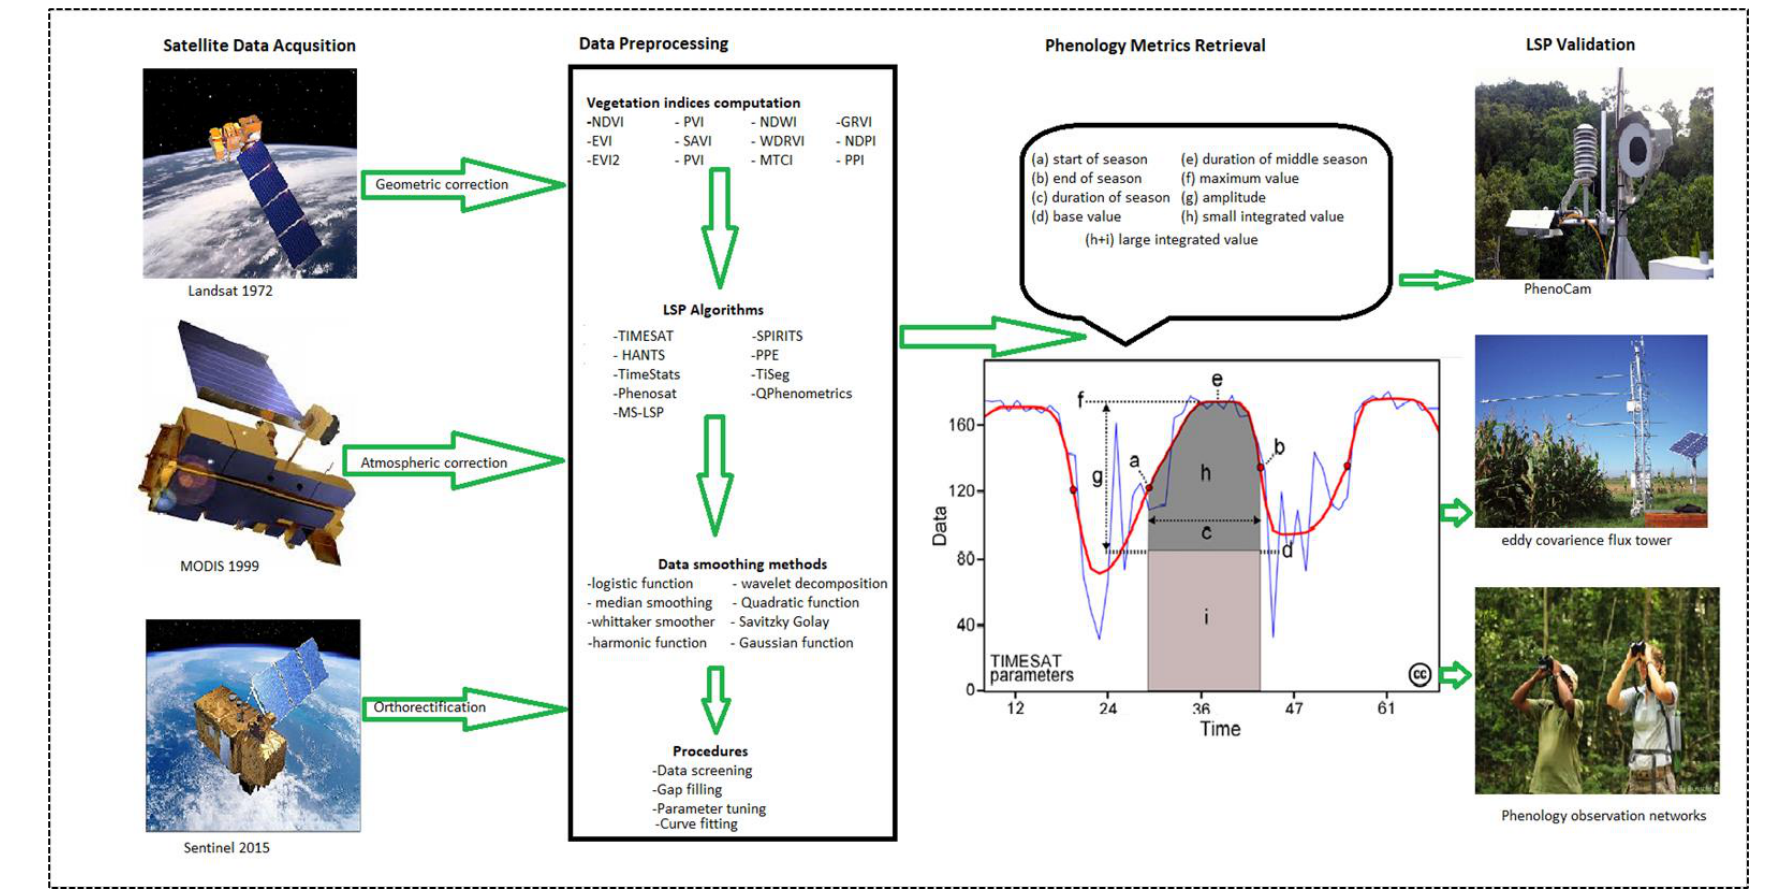
Figure 2. Summary of the common procedures followed in estimating and monitoring LSP in rangelands.